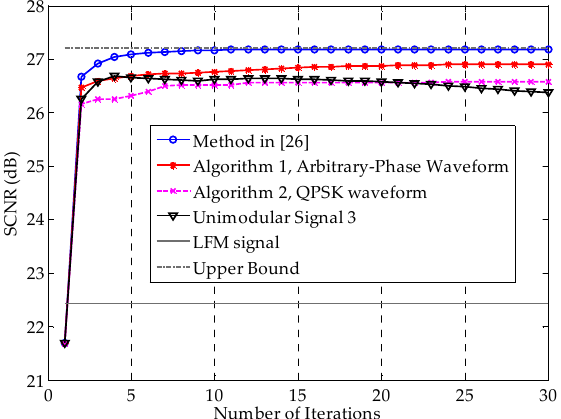
Figure 5. SCNR performances as a function of the number of iterations for different methods. The initial waveforms are identical for all methods. Algorithms 1 and 2 are the arbitrary-phase and QPSK signal design methods proposed in Section 3, respectively. Unimodular Signal 3 denotes the unimodular signal with the phase that results from the method in [26], i.e. , a modulus normalized version of the waveform obtained under the total energy constraint. The upper bound is the limiting value of the SCNR obtained using the method in [26]. The SCNR of the LFM signal does not vary with the iterations, because this signal is fixed.